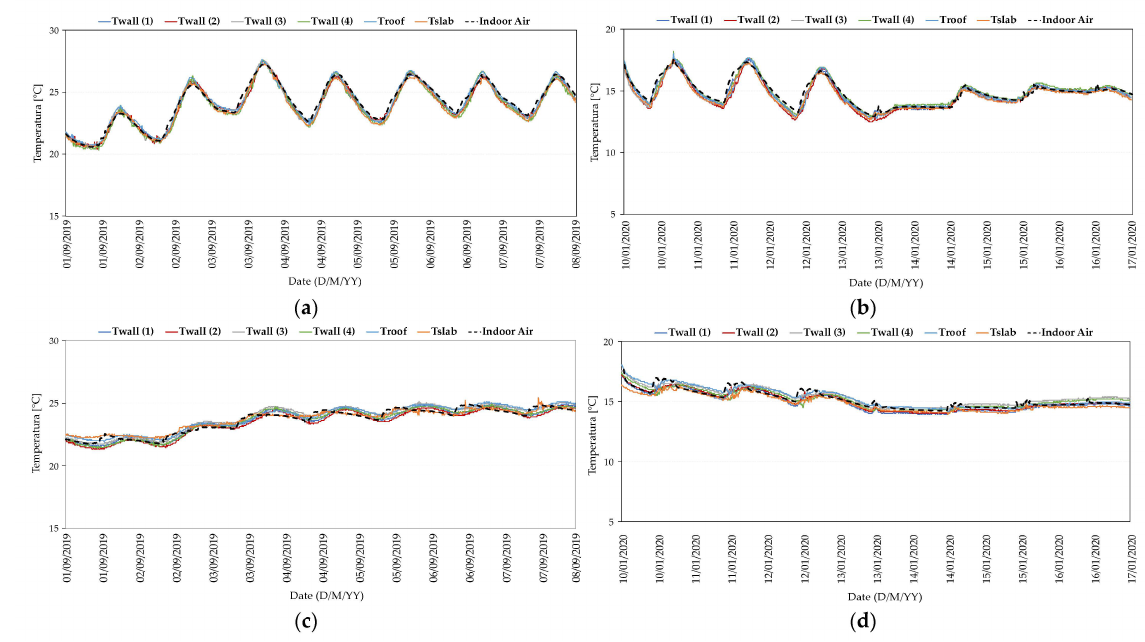
Figure 4. Indoor air and surface temperatures of the walls, roofs, and slabs of the LSF and HBM experimental test cells: ( a ) summer week—LSF test cell; ( b ) winter week—LSF test cell; ( c ) summer week—HBM test cell; ( d ) winter week—HBM test